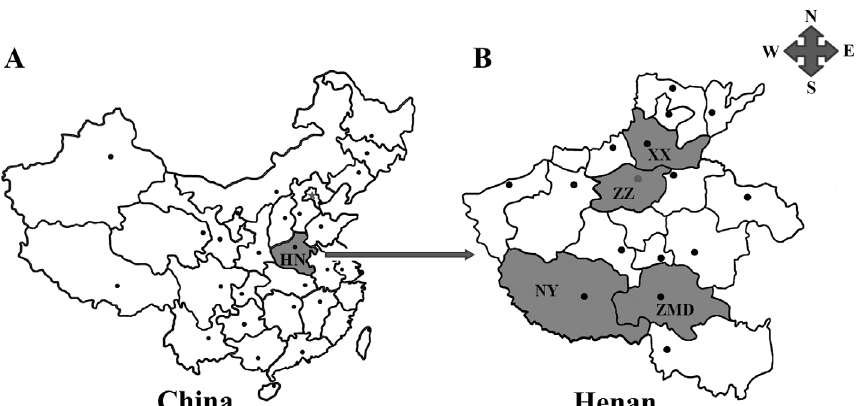
Figure 1. Geographic distribution of the sampling sites in Henan province, central China used in this study. (A) Henan province (HN, shadowed areas) is located in the central part of mainland China. (B) Shadowed areas are the sampling locations for the present survey.